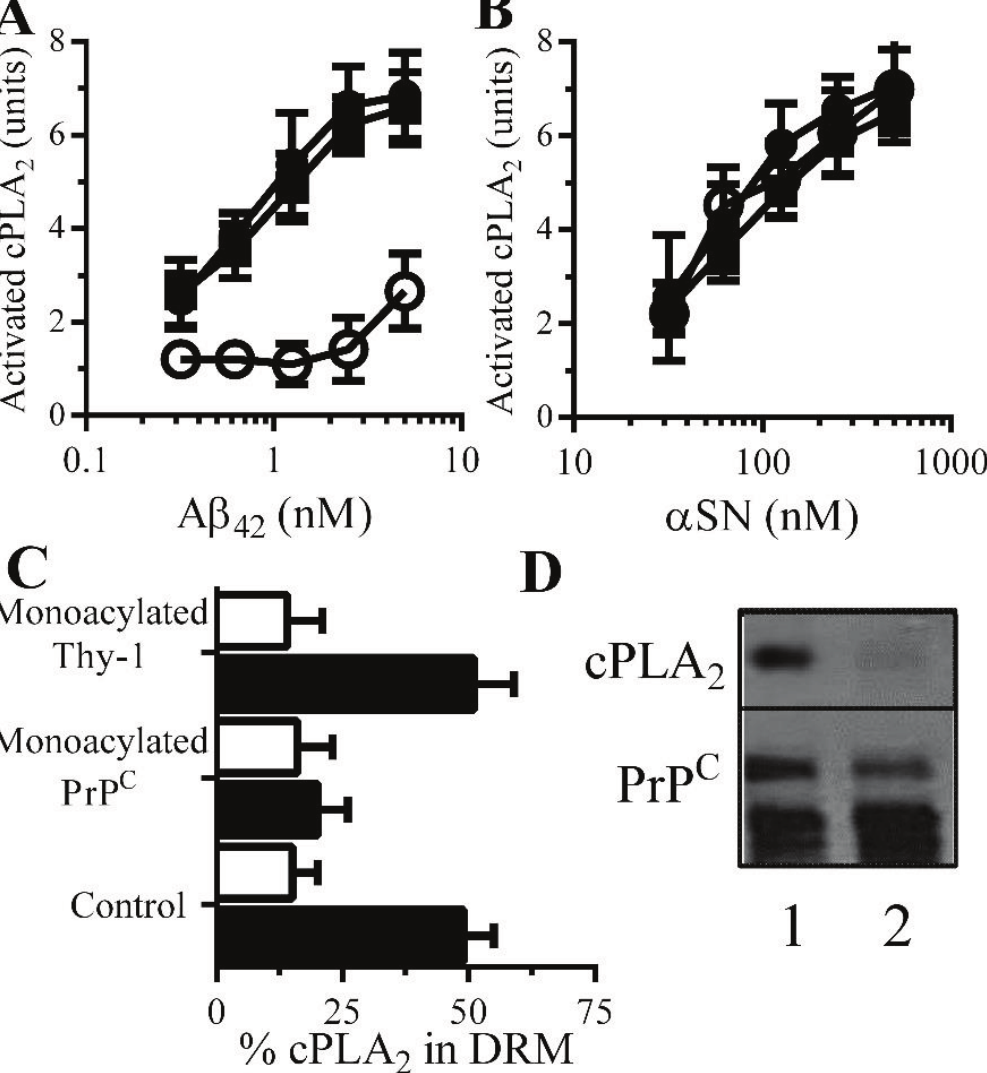
Figure 6. Monoacylated PrP C reduced Aβ -induced activation of cPLA 2 in synaptosomes: The amounts of activated cPLA 2 in synaptosomes pre- treated with control medium (●), 10 nM monoacylated PrP C (○) or 10 nM monoacylated Thy - 1 (■) and incubated with Aβ 42 ( A ) or αSN ( B ) for 1 h. Values are means ± SD from triplicate experiments performed three times ( n = 9). ( C ) The amounts of cPLA 2 in DRMs (rafts) from synaptosomes pre-treated with control medium, 10 nM monoacylated PrP C or 10 nM monoacylated Thy-1 and incubated with control medium (□) or 10 nM Aβ 42 (■) for 1 h . ( D ) Blot showing the amounts of cPLA 2 and PrP C in immunoprecipitates from synaptosomes treated with control medium (1) or 10 nM monoacylated PrP C (2) and incubated with the PrP C -reactive mAb (4F2) for 1